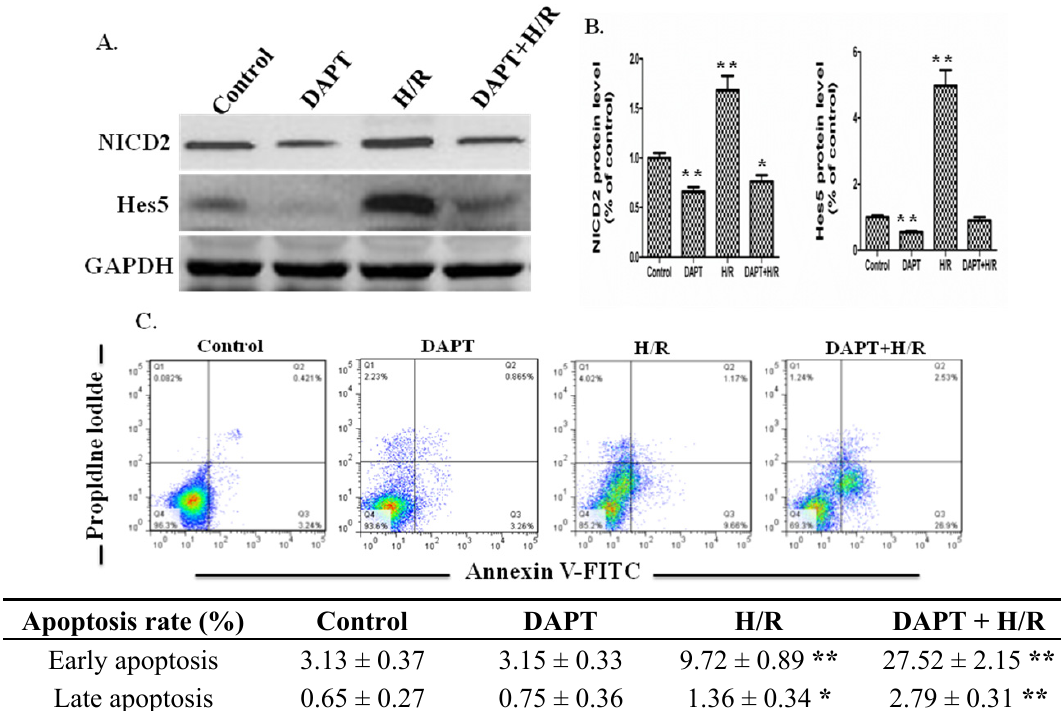
Figure 4. Inhibition of Notch signaling by DAPT increased cell apoptosis of IEC-6 cells receiving H/R. ( A ) IEC-6 cells were plated onto a 6-well culture plate and DAPT (20 μ M) was added. Protein was extracted from IEC-6 cells and protein expression of NICD2 and Hes5 was examined by Western blot. GAPDH was used as the loading control; ( B ) Graphic representation of relative expression of NICD2 and Hes5 normalized to GAPDH. Data are given as the means ± SDs ( n = 5). ** p < 0.01 vs. control group; * p < 0.05 vs. control group; ( C ) Flow cytometry was applied to examine the apoptosis of IEC-6 cells with apoptosis markers (FITC-Annexin V and PI). In the apoptosis map, FITC-Annexin V+/PI+ indicates late apoptosis, FITC-Annexin V+/PI − indicates early apoptosis, and FITC-Annexin V − /PI − indicates normal live cells. H/R and DAPT + H/R increased the early apoptosis and late apoptosis of IEC-6 cells compared to control group. Data are given as the means ± SDs ( n = 5). ** p < 0.01 vs. control group; * p < 0.05 vs. control